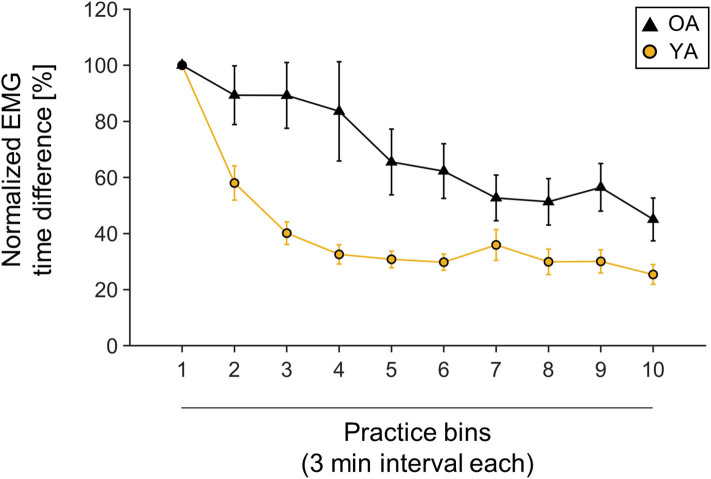
Muscle onset asynchrony (MOA) values normalized to first bin performance. One bin is calculated as one averaged 3-min interval. Yellow line indicates young participants' mean performance; black line indicates older participants mean performance. Mean values and corresponding standard deviation of the mean are depicted.